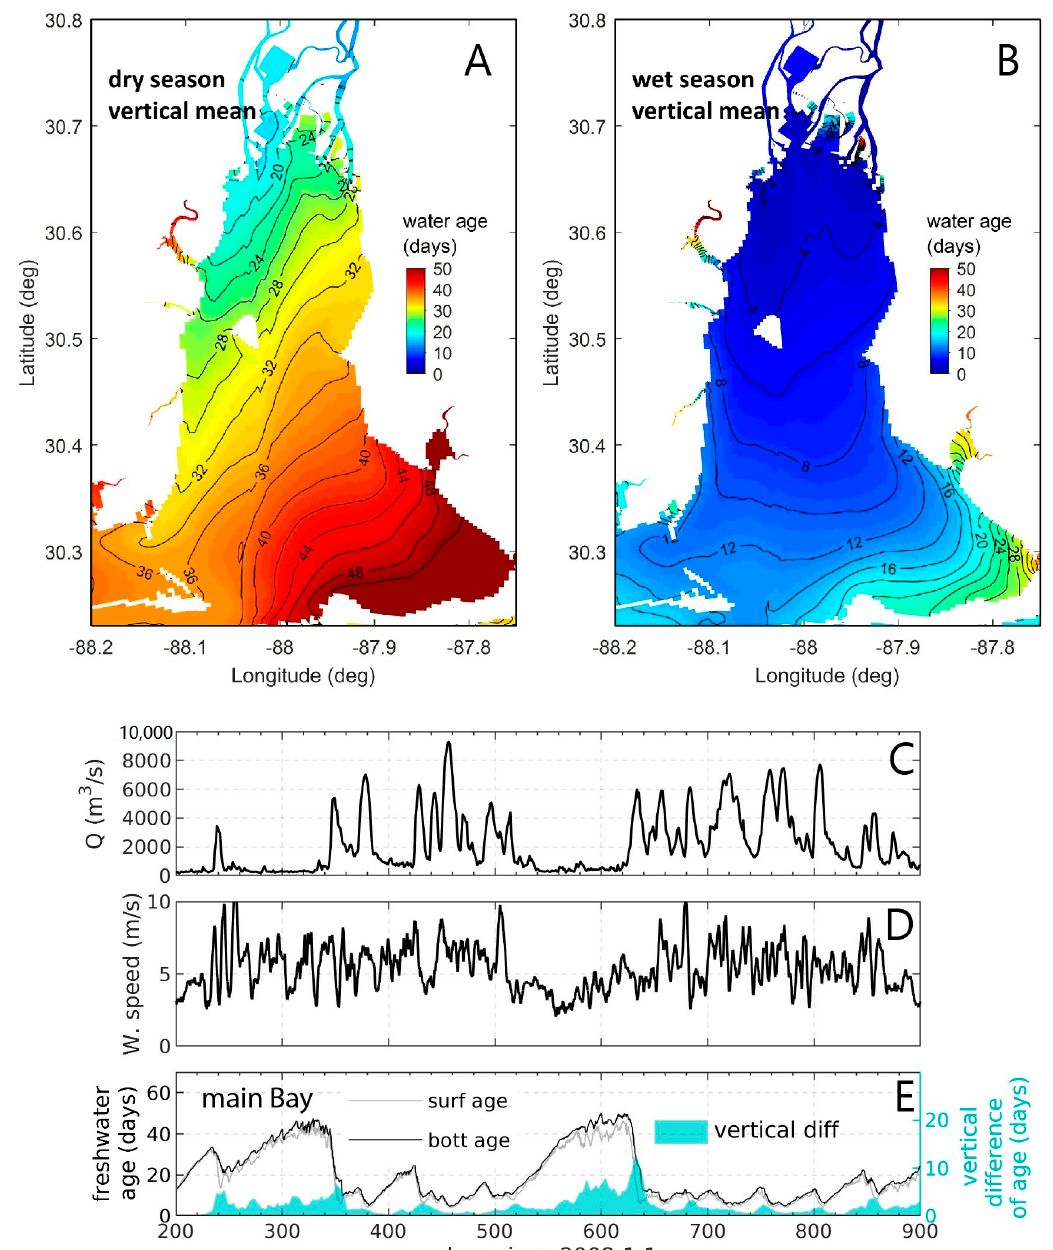
Figure 24. Maps of computed vertical mean freshwater age in Mobile Bay for ( A ) the dry season and ( B ) the wet season, based on the 3D numerical modeling of Du et al. [243]. Timeseries of ( C ) river discharge, ( D ) wind speed, and ( E ) computed freshwater age averaged over the main bay. For the age timeseries, surface water is gray, bottom water is black, and the vertical age difference is cyan [243]. (Modified with permission from J. Du, Journal of Geophysical Research: Oceans; published by Wiley, 2018).